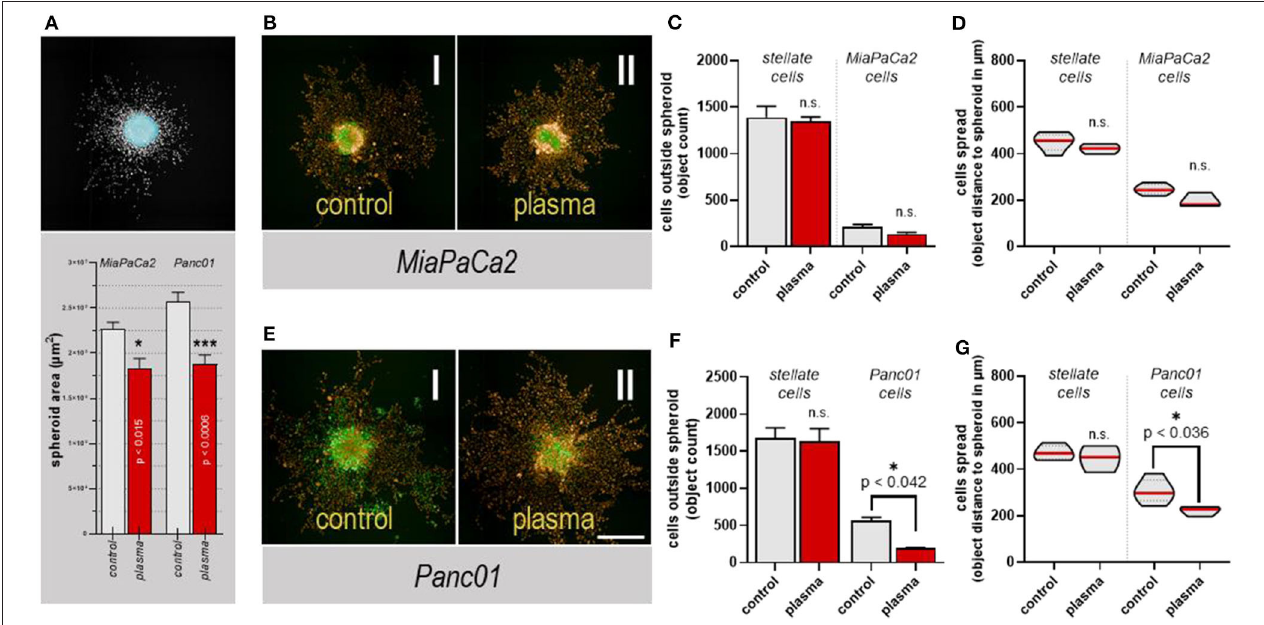
FIGURE 6 | Plasma treatment reduced cancer cell outgrowth in a matrix-3D-tumor model. (A) Representative images of a software-calculated, highly-contrasted image of the spheroid with the algorithm-based detection of the spheroid core area are as well as its quantification at the bottom; (B) representative images of (I) untreated and (II) 120s plasma-treated spheroids of co-cultured MiaPaCa2 Green + RLT-PSC Red, in Matrigel 72h after the treatment; (C) the quantification of the cell count outside the spheroid region; (D) the quantification of the cells’ absolute distance to the spheroid core; (E) representative images of (I) untreated and (II) 120s plasma-treated spheroids of co-cultured Panc01 Green + RLT-PSC Red, grown in Matrigel 72h after the treatment; (F) the quantification of the cell count outside the spheroid region; (G) the quantification of the cells’ absolute distance to the spheroid core. The data show (A,C,F) mean + SEM and (D,G) mean and 25% and 75% quartiles in violin plots, and are from 2 to 3 replicates of two independent experiments. Scale bar is 150 µ m.